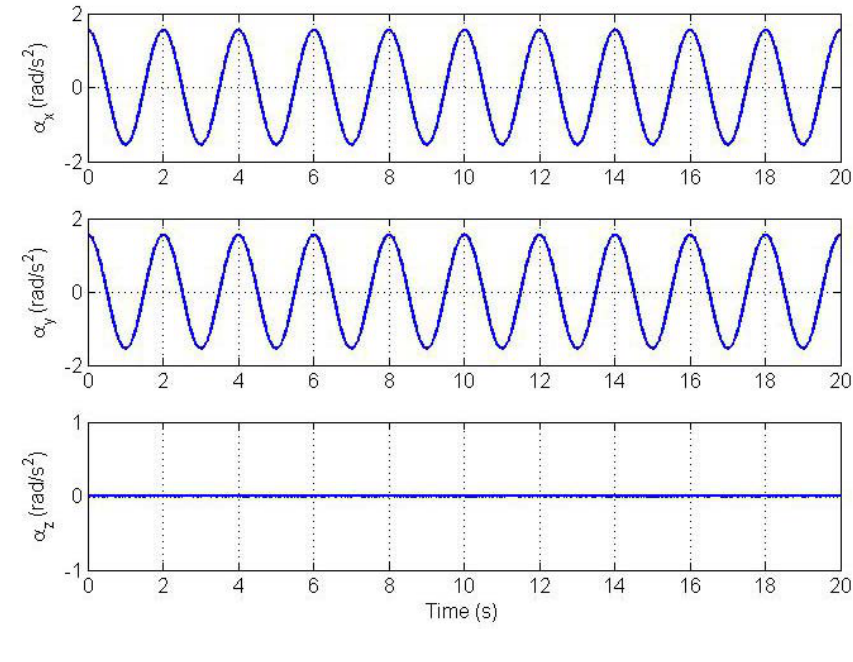
Figure 3. Angular acceleration trajectory profile.